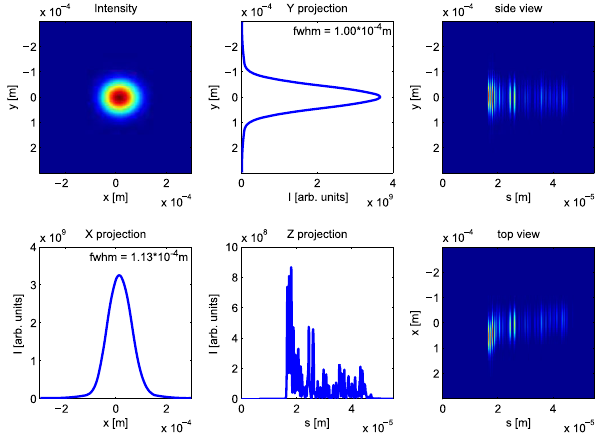
FIG. 7. Radiation distribution at the end of SASE undulator in time domain. The average photon energy is 1000 eV. Left figure in first row is the transverse intensity distribution. Right figures represent projections of intensity distributions. Here and below spatial-time domain is represented in spatial coordinates x , y , and s ¼ ct